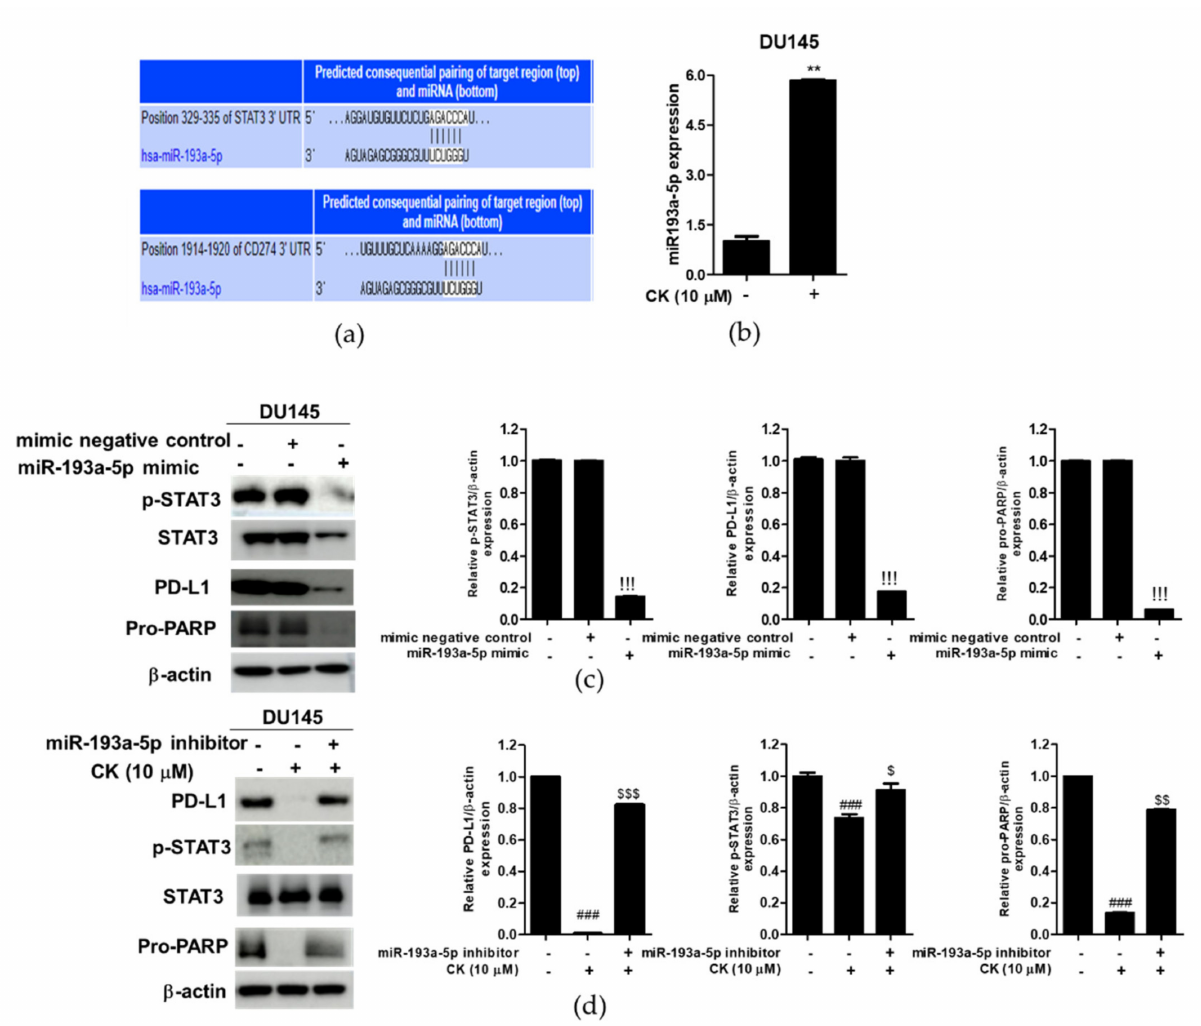
Figure 8. The important role of miR-193a-5p in CK-induced apoptosis in DU145 cells. ( a ) The TargetScan web server demonstrates that miR-193a-5p directly binds to the 3 (cid:48) -untranslated region of STAT3 and PD-L1. ( b ) Effect of CK on miR193a-5p expression by qRT-PCR in DU145 cells. ( c ) Effect of miR193a-5p mimic on p-STAT3, STAT3, PD-L1 and pro-PARP in DU145 and cells. ( d ) Effect of miR193a-5p inhibitor on p-STAT3, STAT3, PD-L1, pro-PARP in DU145 cells. Data are shown as means ± SD. ** p < 0.001 versus untreated control. !!! p < 0.001 versus mimic negative control. ### p < 0.001 vs. untreated control. $ p < 0.05, $$ p < 0.01 and $$$ p < 0.001 versus CK-treated